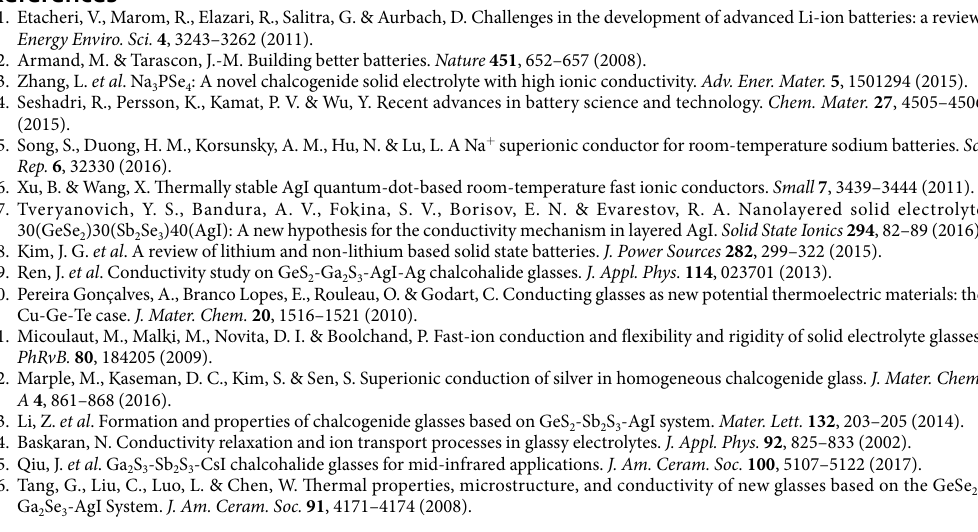
Methods Glass preparation.